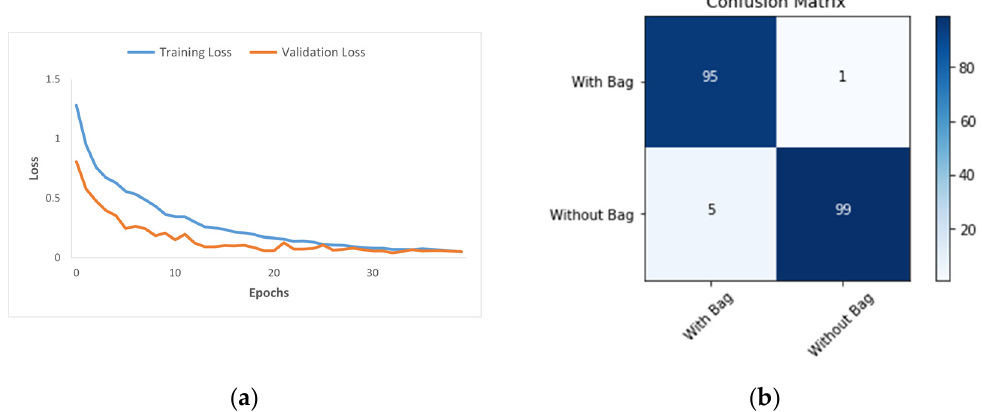
Figure 8. The loss curve and confusion matrix of the first experiment on INRIA, ILIDS, and MSMT17 datasets: ( a ) The loss curve, ( b ) the confusion matrix.